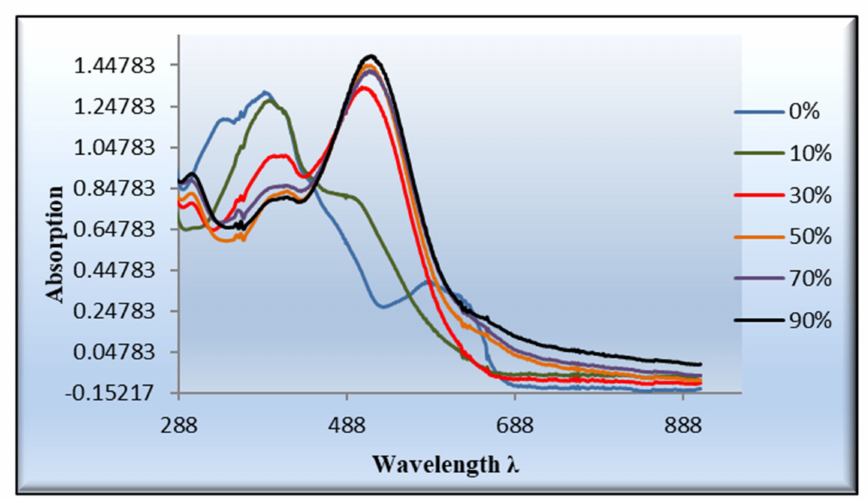
Figure 2. Wavelength of 4a in the presence of increasing [H + ] in a DMF.